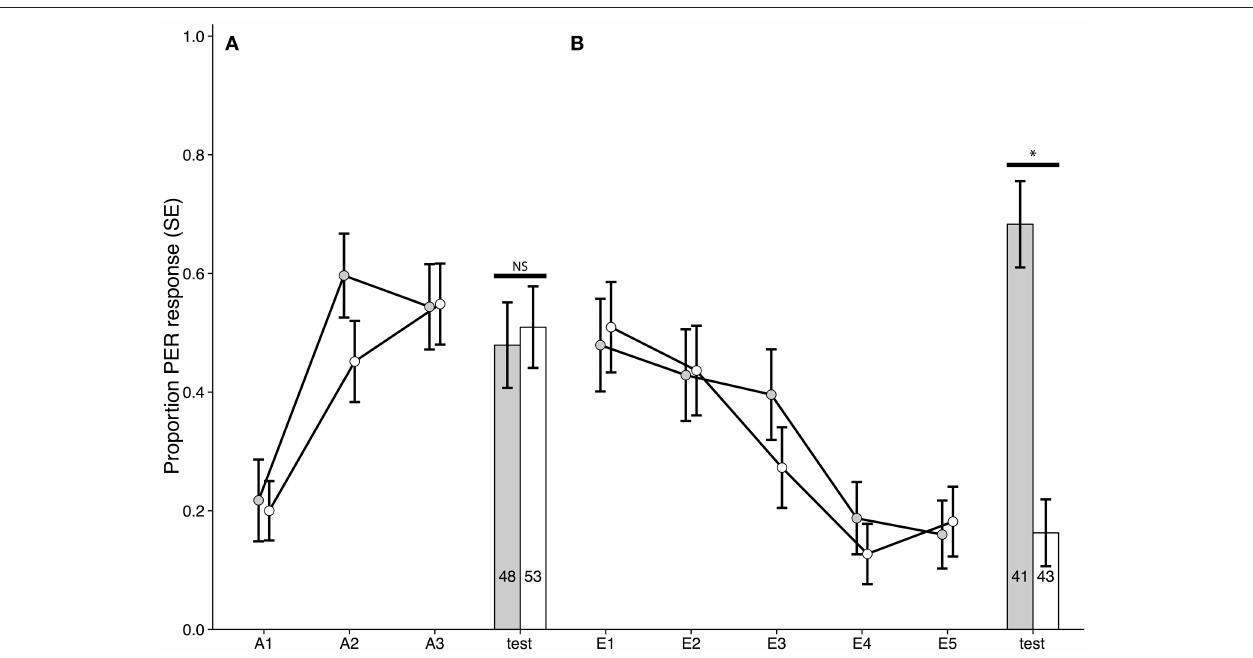
FIGURE 5 | Experiment 6: results for bees trained in a single odor conditioning PER paradigm. Cocaine treatment was given 1h after extinction training. (A) Acquisition test ( χ 2 = 0.0109, p = 0.9167, n = 101). (B) Extinction test ( χ 2 = 21.2706, p < 0.000001, n = 84, φ = 0.5032). Note that for extinction memory, lack of PER expression signifies successful memory formation. *Denotes statistically significant differences.